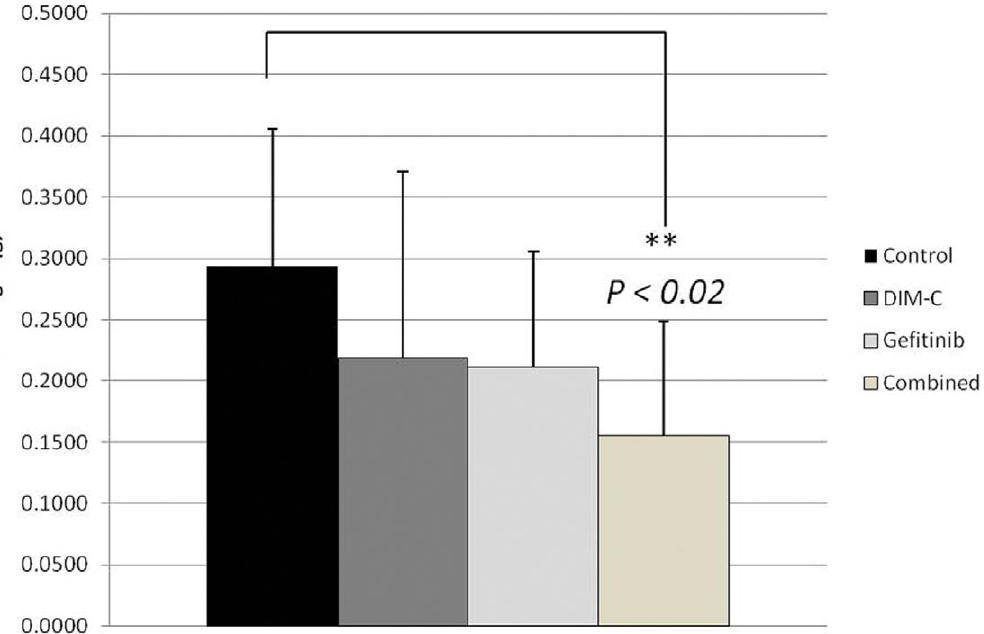
Figure 4. Effects of combination therapy invivo . Bladder tumor growth of combination treatment arm compared to control arm (P , 0.02). Ten mice per group were treated with placebo; DIM-C was given 60 mg/Kg 3 times per week; Gefitinib was given 2 mg/day, 5 times per week. All drugs were administrated by oral gavage. Treatment was continued for 4 weeks.